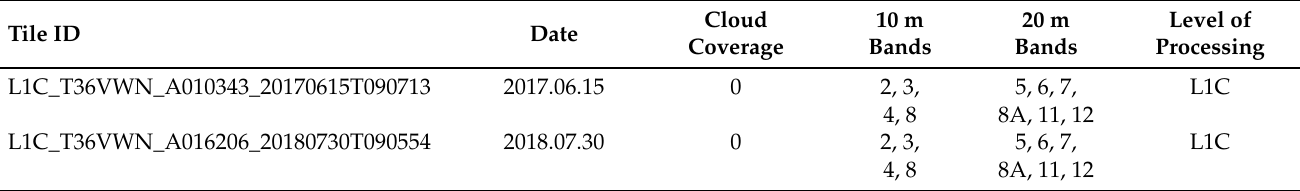
Table 2. Sentinel-2 images from USGS. Wavelength values corresponding to each band: Band 2: Blue, 458–523 nm; Band 3: Green, 543–578 nm; Band 4: Red, 650–680 nm; Band 5: Red-edge I (R-edge I), 698–713 nm; Band 6: Red-edge II (R-edge II), 733–748 nm; Band 7: Red-edge III (R-edge III), 773–793 nm; Band 8: Near infrared (NIR), 785–900 nm; Band 8A: Narrow Near infrared (NNIR), 855–875 nm; Band 11: Shortwave infrared-1 (SWIR1), 1566–1651 nm; Band 12: Shortwave infrared-2 (SWIR2), 2100–2280